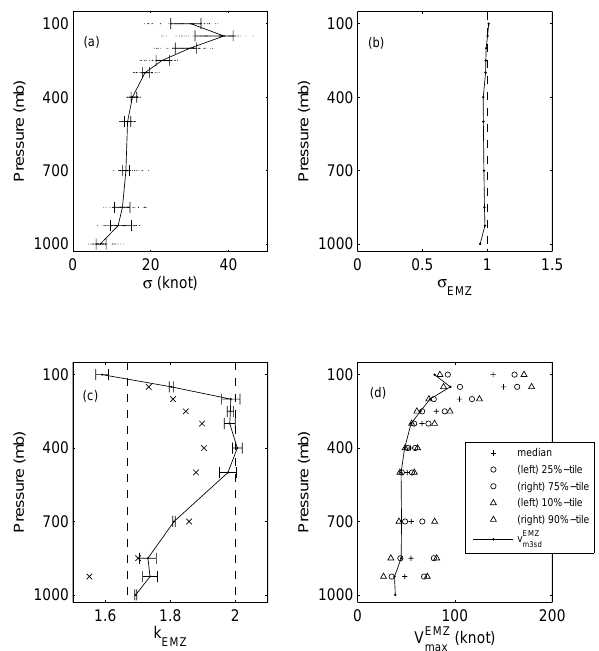
Fig. 9. (a) Scatter plot of rms wind speed σ computed using Eq. (2) at all 43 stations in the Equatorial Monsoon Zone (EMZ). The verti- cal profile connects the median values and delimited horizontal bars denote the inter-quartile ranges. (b) The rms value σ EMZ of non- dimensional wind speed u = v/σ computed from the fitted Weibull distribution of u in EMZ using Eq. (2). (c) The shape parameter k EMZ describing the fitted Weibull distribution of u in EMZ with error bars shown. Crosses denote theoretical lower bound for k for wind anomaly magnitude. (d) The spread of threshold wind speed (symbols) among the stations in EMZ compared to